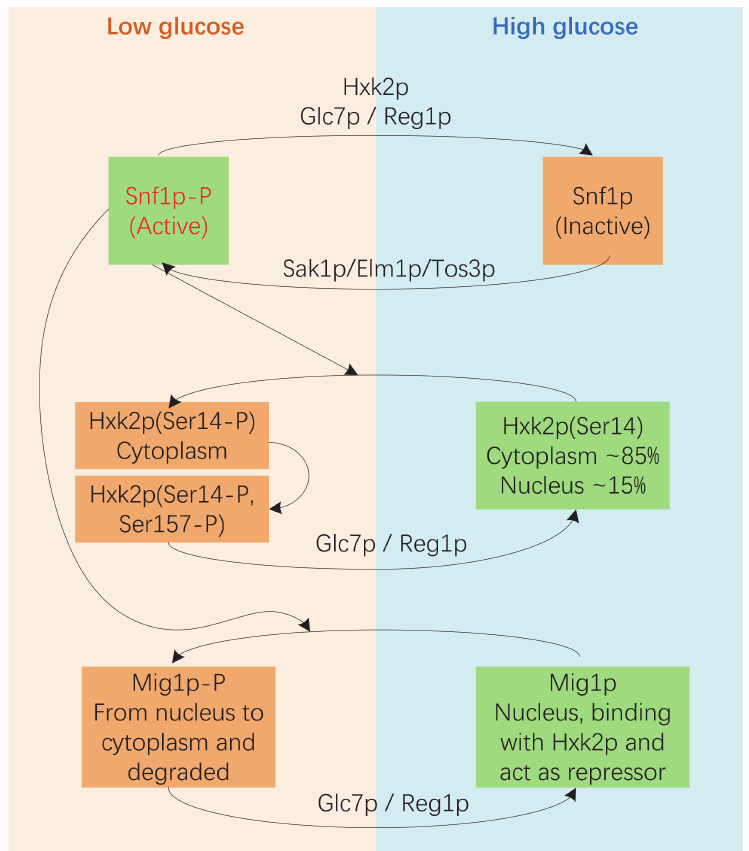
Figure 1. Hxk2p participates in the Snf1p-Mig1p pathway. Under high-glucose conditions, Snf1p is dephosphorylated by the Glc7p-Reg1p protein phosphatase, and Hxk2p is essential for this process. The dephosphorylated form of Snf1p is inactive. Hxk2p and Mig1p are in their dephosphorylated forms and function in glucose repression. In a low glucose environment, Snf1p is phosphorylated by Sak1p / Elm1p / Tos3p. The phosphorylated Snf1p is active and phosphorylates Hxk2p at serine 14, which a ff ects the shuttling of Hxk2p. The active form of Snf1p also phosphorylates Mig1p, and this directly leads Mig1p to move from the nucleus to the cytoplasm. The Mig1p in the cytoplasm is ubiquitinated and degraded by proteases